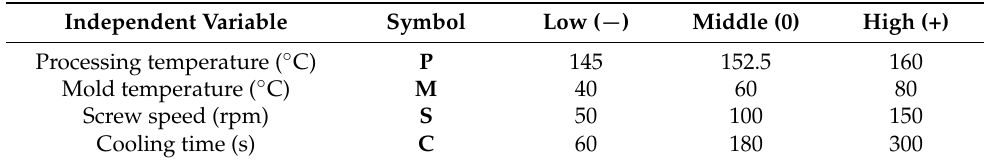
Table 2. FFD test matrix with melt processing factor symbols ( P , M , S , C ), low ( − ), middle (0), and high (+) levels.